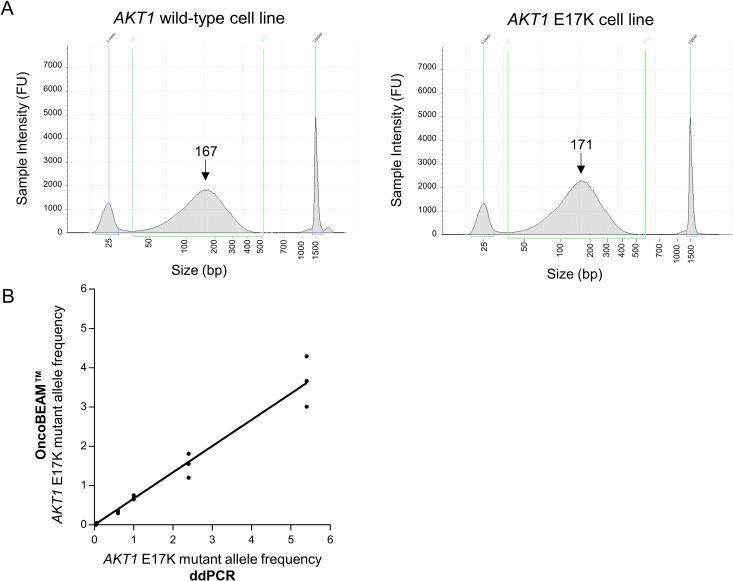
AKT1 E17K ctDNA reference standard for OncoBEAM™ evaluation.(A) Representative TapeStation (D1000 screentape) graphs showing the DNA sizes from a wild-type AKT1 (left) and an AKT1 E17K harboring (right) cell line sample upon fragmentation by Covaris prior to spiking into plasma. The arrows demonstrate the average peak size. (B) Graph presenting the AKT1 E17K mutant allele frequencies detected in the ctDNA reference standard samples analyzed in triplicate by the OncoBEAM™ assay (presented on the y-axis) and ddPCR assay (presented on the x-axis).